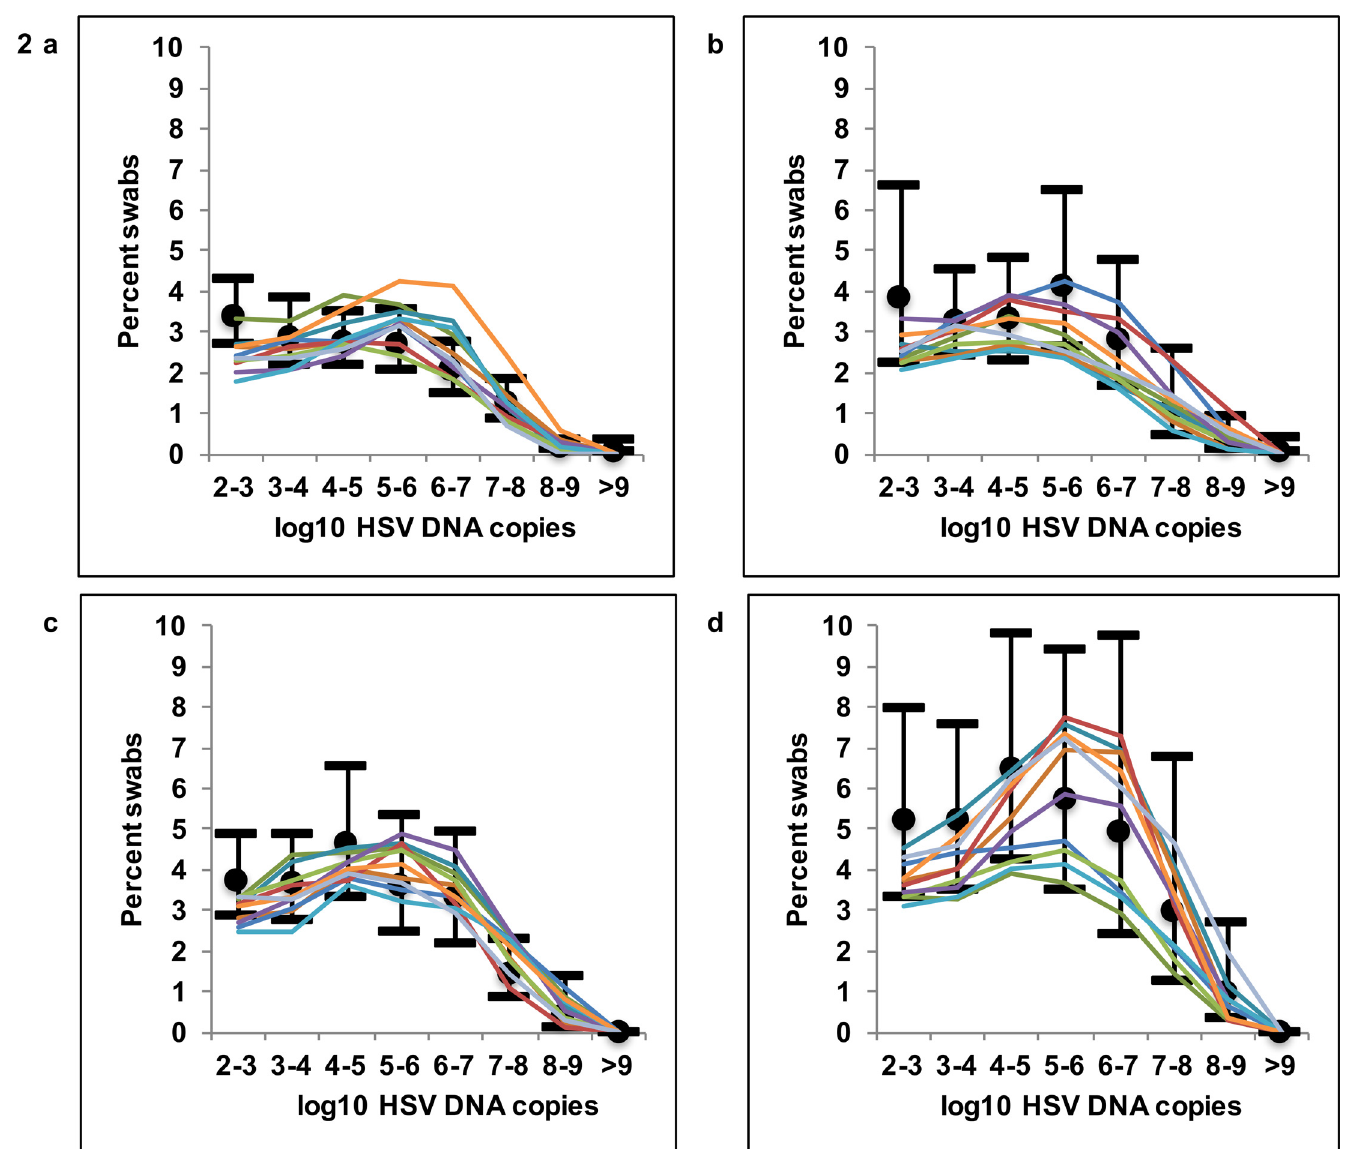
Fig 2. Mathematical model fit to quantitative shedding rate and episode rate. Ten mathematical model simulations of HSV-2 shedding (thin colored lines) in reference to empirical shedding data (median marked with black dot and 95% CI with black horizontal bars). Quantitative shedding per swab for (A) HIV negative, and HIV positive men with (B) CD4+ T-cells > 500/ μ L, (C) 200-499/ μ L and (D) < 200/ μ L.